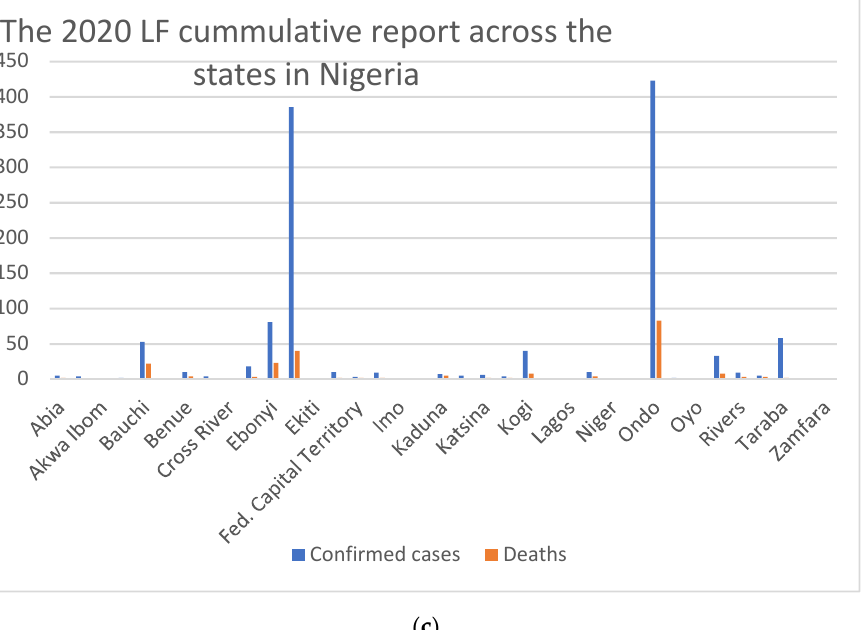
Figure 1. ( a ) Trend in confirmed cases of LF by epidemiological week from year 2018 to 2022. The COVID-19 pandemic era showed the highest number of LF cases recorded compared to previous years. The data also show a high increase in new cases of LF in the current year (2022) during the harmattan season (dry season) as the Nigerian Center for Disease Control (NCDC) continues to see a concurrent rise in new cases of COVID-19 infections in hospitals. In 2021, LF cases plummeted as large number of people became vaccinated against COVID and due to continuous implementation of COVID-19 infection control measures. ( b ) Shows the surge in COVID-19 infection with a concurrent rise in Lassa fever in 2020. The COVID-19 infection rate was high across the 36 states in the country, outnumbering the cases of LF even. Data obtained and reprinted with permission from the Nigerian Center for Disease Control (NCDC) (copywrite 2022) [15]. ( c ) The 2020 Lassa fever epidemiology cases across the states in Nigeria. Data obtained from the Nigerian Center for Disease Control [15].